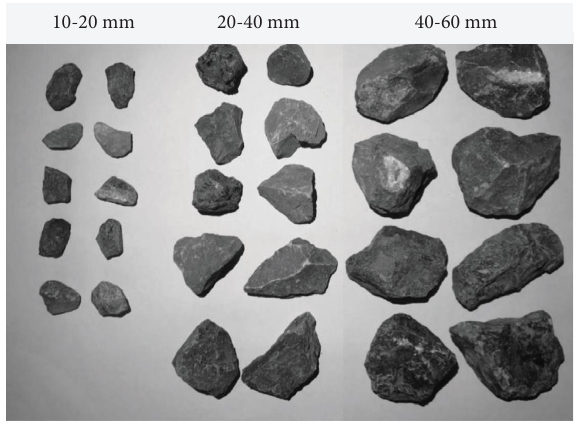
Figure 1: Limestone particles of diferent groups, 10–20mm, 20–40mm, and 40–60mm.